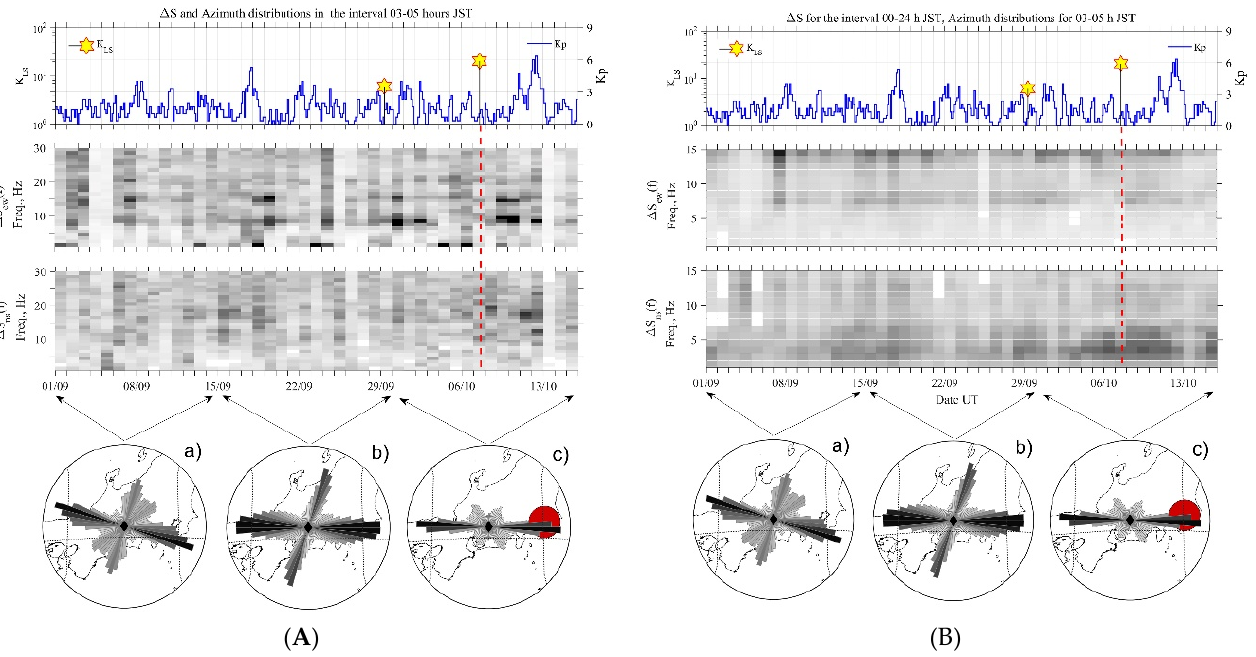
Figure 10. Temporal evolutions of seismic ( K LS ) and geomagnetic ( K p ) activity (top panel), the spectra of Δ S ew and Δ S ns for LT = 3–5 h ( A ) and full-day intervals ( B ) observed from 1 September to 15 October 2021 (second and third panels). The three round panels (( a ),( c )) in the bottom depict the azimuth distributions averaged over 15 days in the 3–5 Hz frequency band.